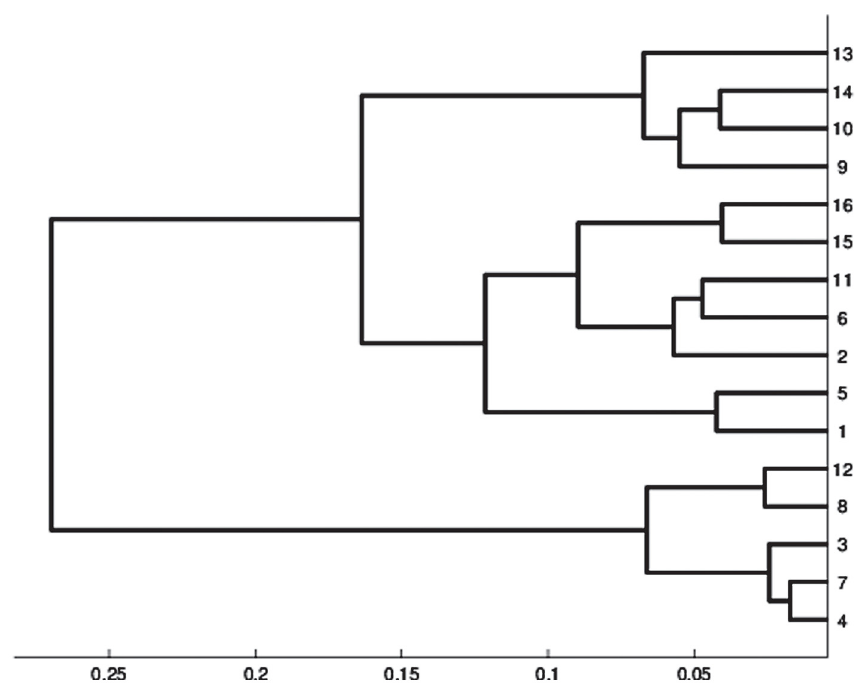
Fig 5. Hierarchical classification. The y axis indicates the macro-classes that are represented in Figs 2 and